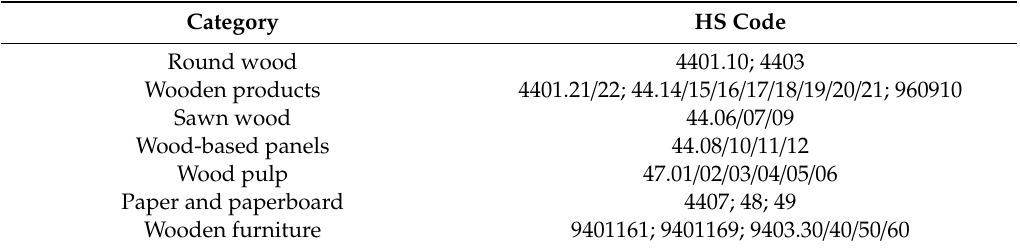
Table 1. The commodity codes (HS codes) involved in the wood processing industry.